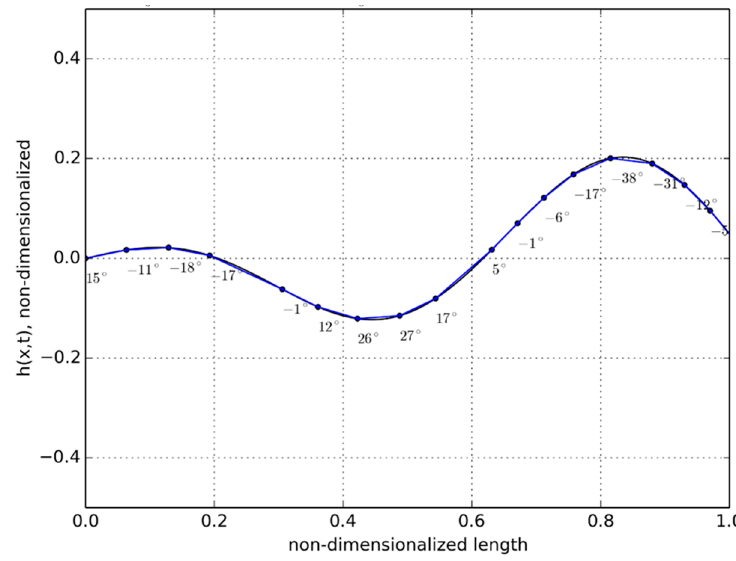
Figure 5. Relative angles at the joints of each segment (t = 2.5 s).